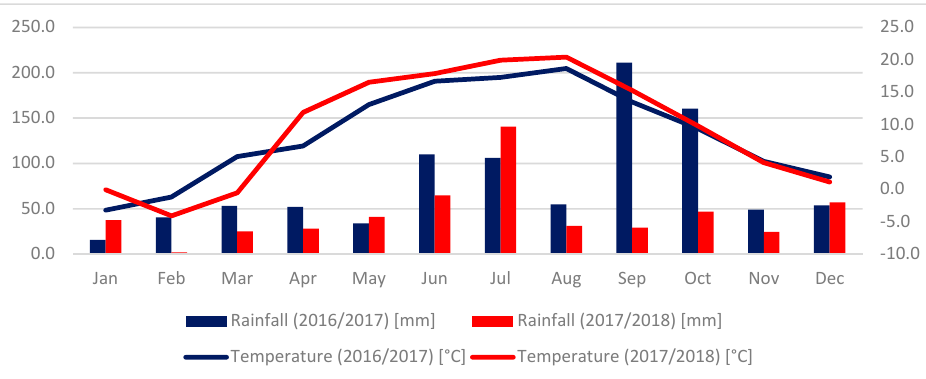
Figure 1. Weather conditions in the growing seasons of 2016/2017 and 2017/2018. Agronomy 2020 , 10 , x FOR PEER REVIEW